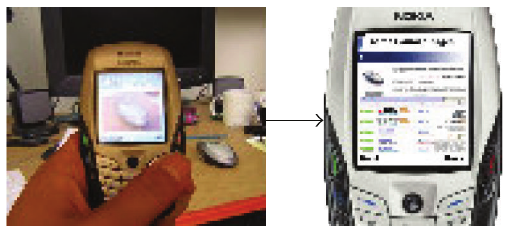
Figure 1: Mobile image-based web